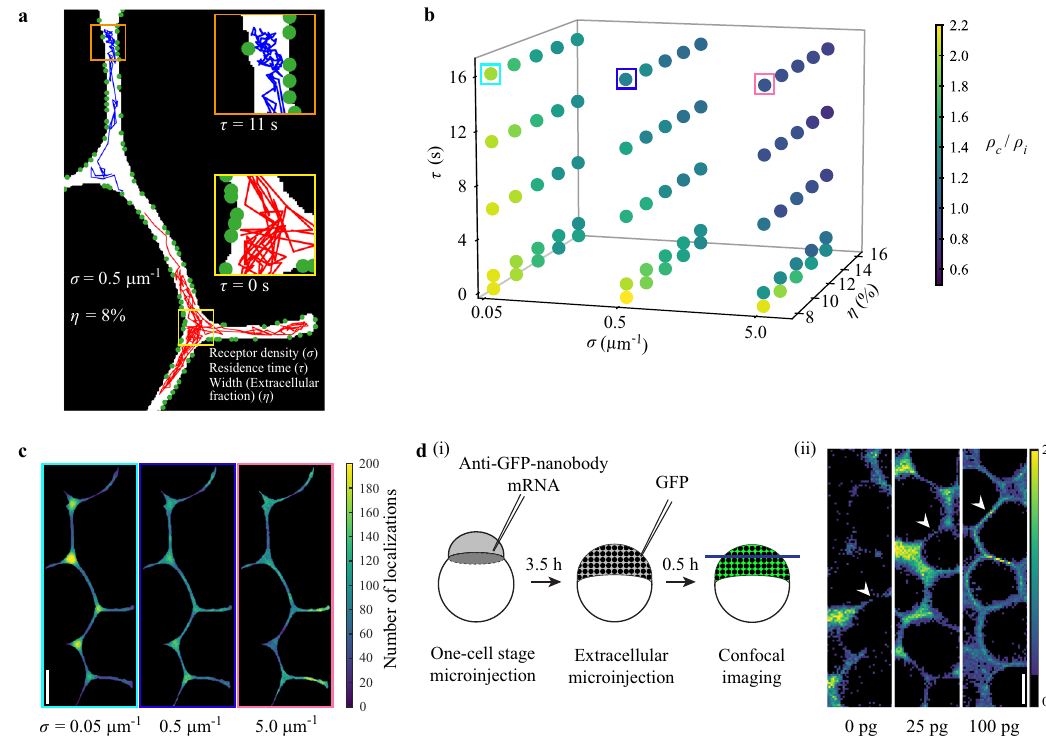
Fig. 6 | An agent-based model reveals key parameters affecting morphogen behavior in the extracellular space. a Illustration of the model with a section of the two-dimensional simulation geometry showing simulated tracks (200 steps or 2s) for two morphogens with residence times τ of 11s (blue track) and 0s (red track),respectively.Greencirclesindicatereceptors.Thereceptordensity σ isgiven as the number of receptors per µ m of membrane length. The width of the extra- cellular region in terms of extracellular fraction is given by the parameter η . Mor- phogens are allowed to move in the extracellular space (white). A morphogen becomes ‘ immobile ’ orboundupondetectingareceptorinproximityandperforms smaller jumps corresponding to the bound diffusion coef fi cient. b Three- dimensional scatter plot of simulated parameter combinations showing corre- sponding localization density ratios ( ρ c / ρ i ). Five residence times τ (0s, 1s, 6s, 11s,